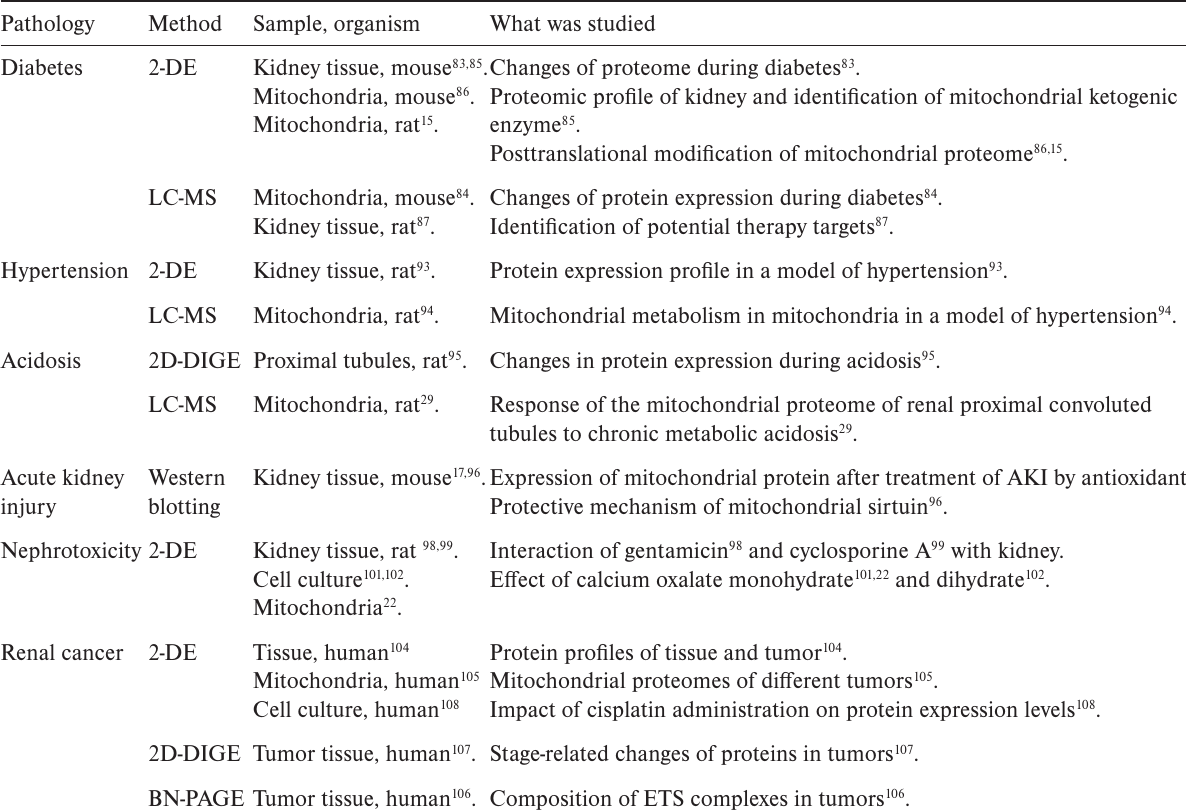
Table 2. Applications of proteomic methods that were used in studies of the most common pathological states of the